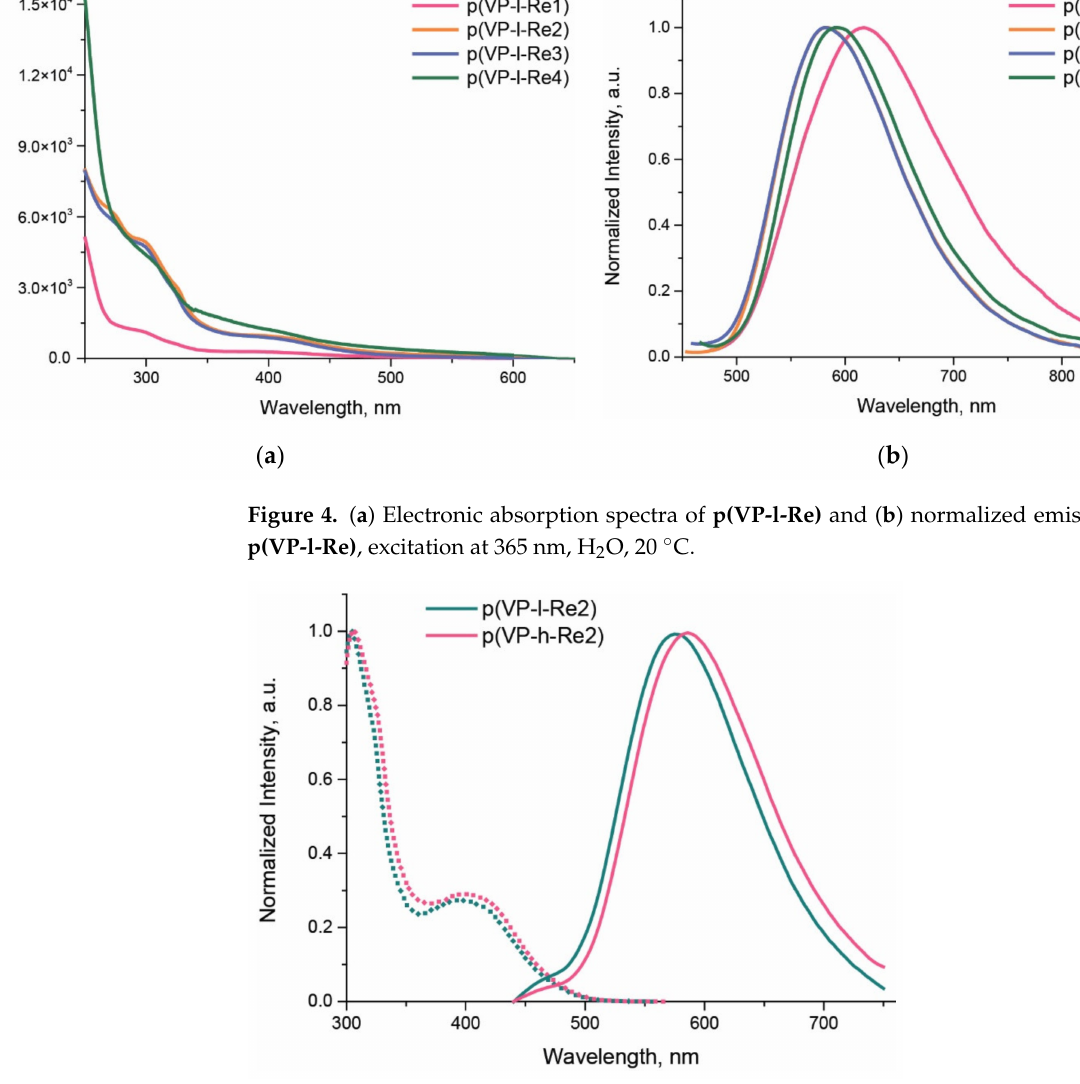
Figure 5. Normalized excitation (dotted line) and emission (solid line) spectra of p(VP-l-Re2) and p(VP-h-Re2) in the mixture of DMEM, serum albumin and PBS (pH 7.4) at 37 ◦